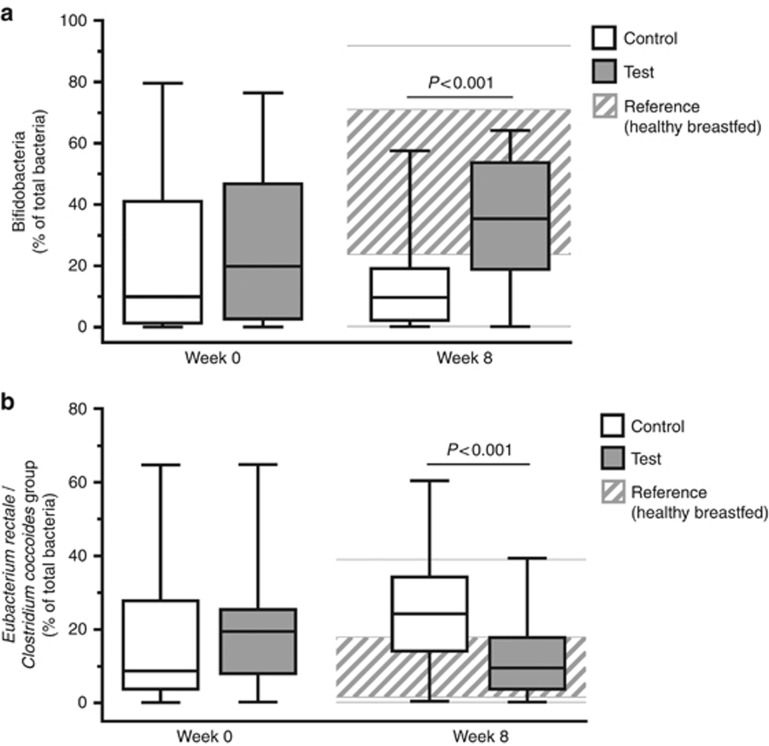
Percentages of bifidobacteria (a) and adult-like ER/CC (b) at weeks 0 and 8 in subjects given test formula or control formula (ITT). The gray shaded area represents the sample 25th to 75th percentile of the healthy reference group (healthy, breastfed subjects), and the gray horizontal lines represent the minimum and maximum values of the healthy reference group. P values are based on ANCOVA comparing test vs. control groups with week 8 values as outcome, stratification factor (skin or gastrointestinal symptoms) and imputed baseline values as covariate and intervention as fixed effect, respectively.